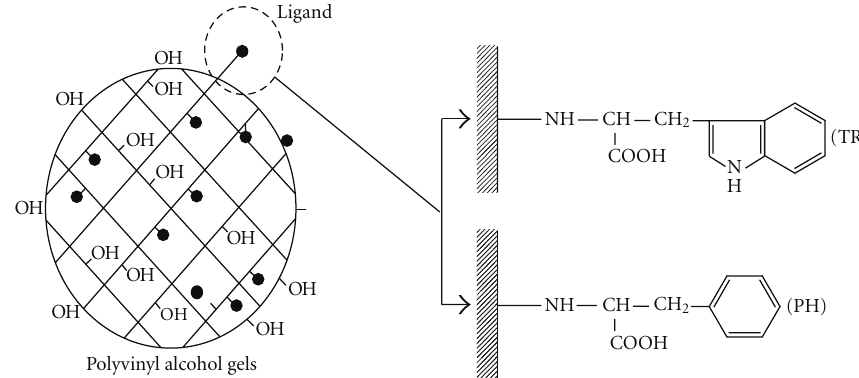
Figure 10: The structural formulas of Immusorba PH-350 and TR-350. These columns covalently bond with the hydroxyl group on the surface of porous polyvinyl alcohol gel with the amino group of amino acid. Immusorba PH-350 is using phenylalanine as ligand and TR-350 is using